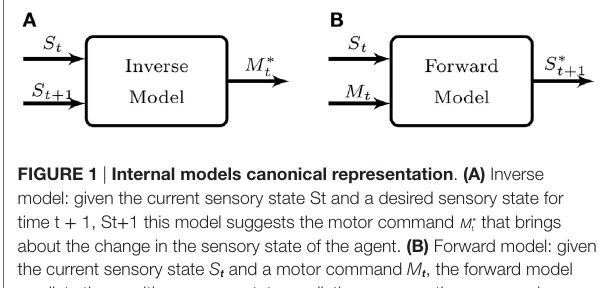
that brings t ∗ , were the command t +∗ 1 and S t + 1 . The former is t +∗ 1